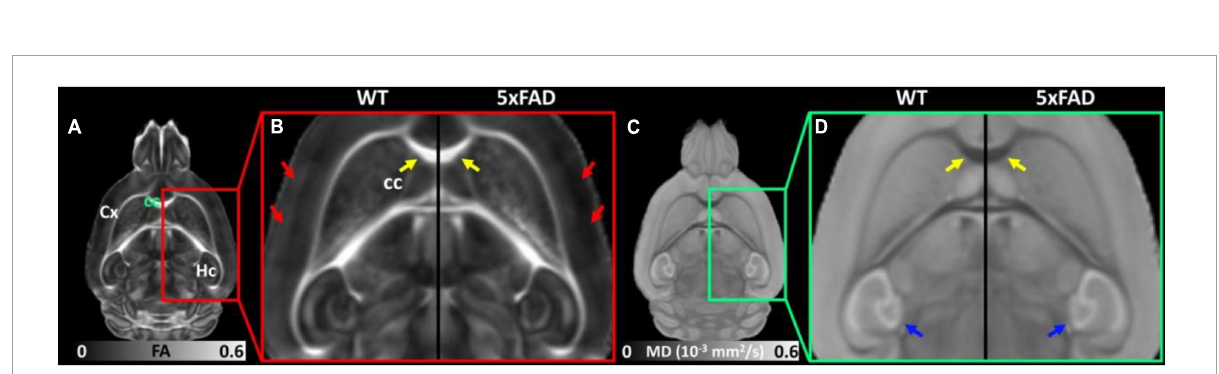
FIGURE2 The representative FA (A,B) and MD (C,D) images of WT and 5xFAD mice at 4 months. There are no apparent FA and MD differences in the corpus callosum (cc, yellow arrows) and hippocampus (Hc, blue arrows) regions. The FA map showed darker (lower FA values) in the cortex (Cx) region of 5xFAD compared to WT (red arrows).